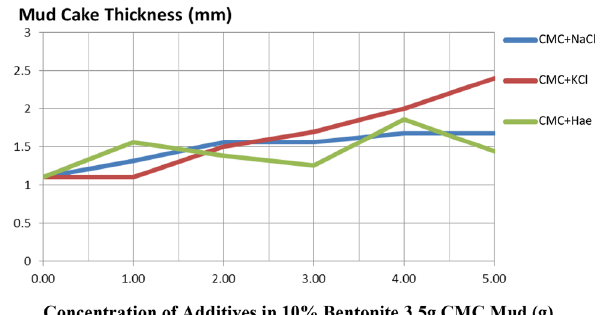
Fig. 9 Effect of NaCl, KCl and haematite on mud cake thickness of CMC–bentonite mud